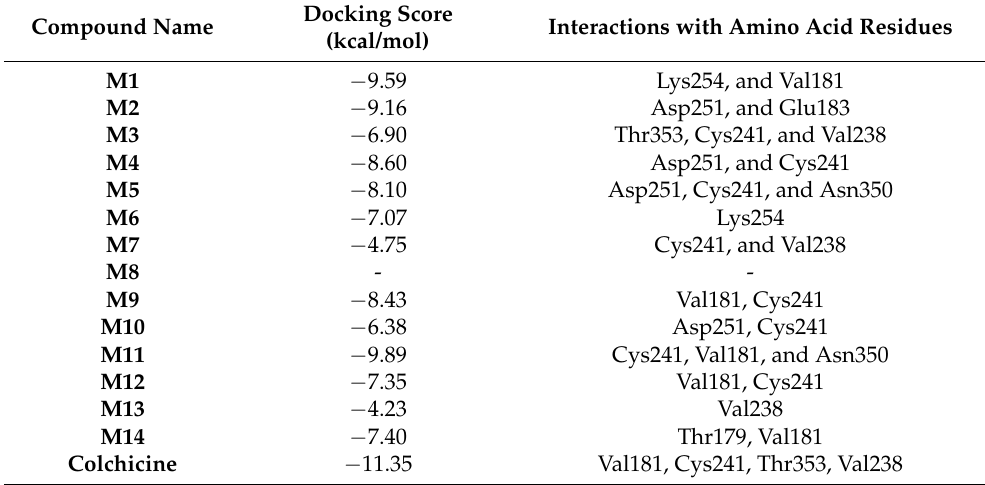
Table 4. Docking scores of identified metabolites with Tubulin crystal structure.